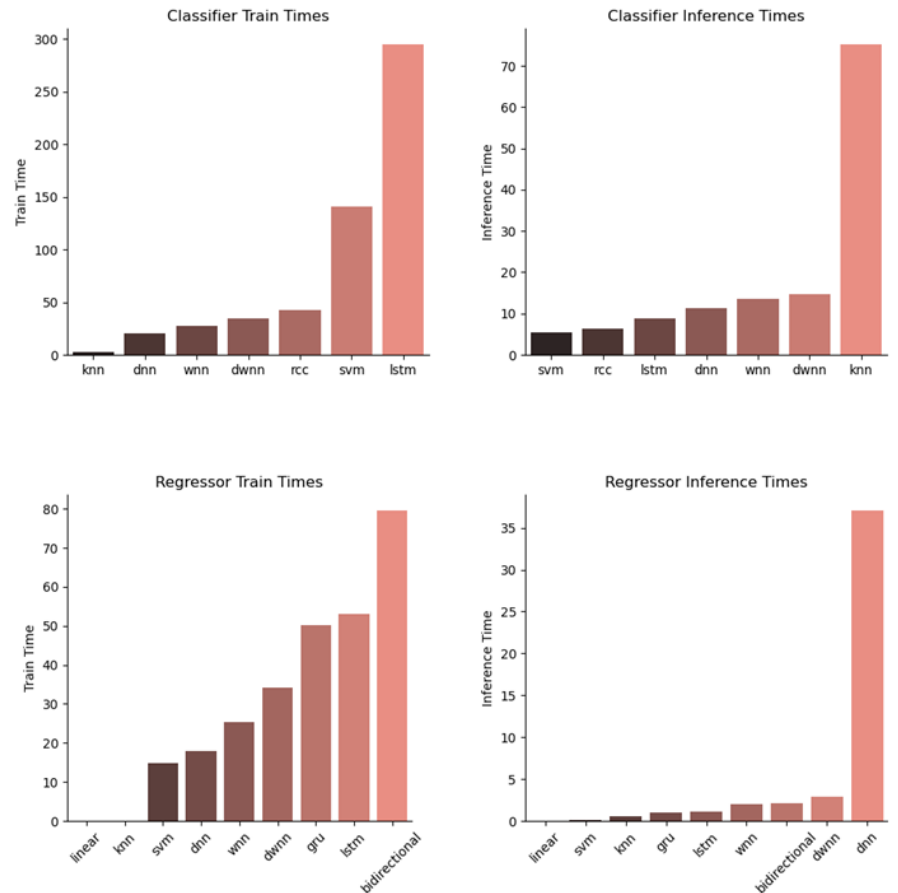
Figure 10. Running time for training and